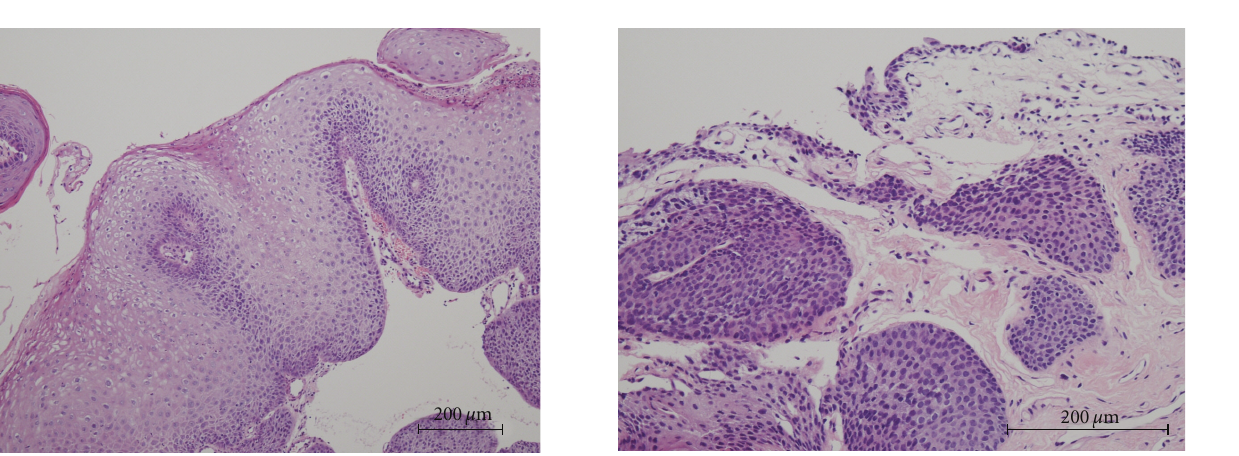
Figure 1: Hematoxylin and eosin staining of HPV11-positive ure- thral condyloma acuminatum showing koilocytosis and parakerato- sis.